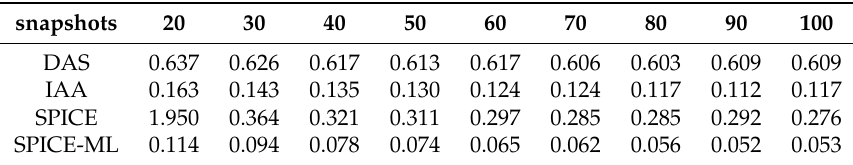
Table 5. RMSE vs. snapshots with coherent